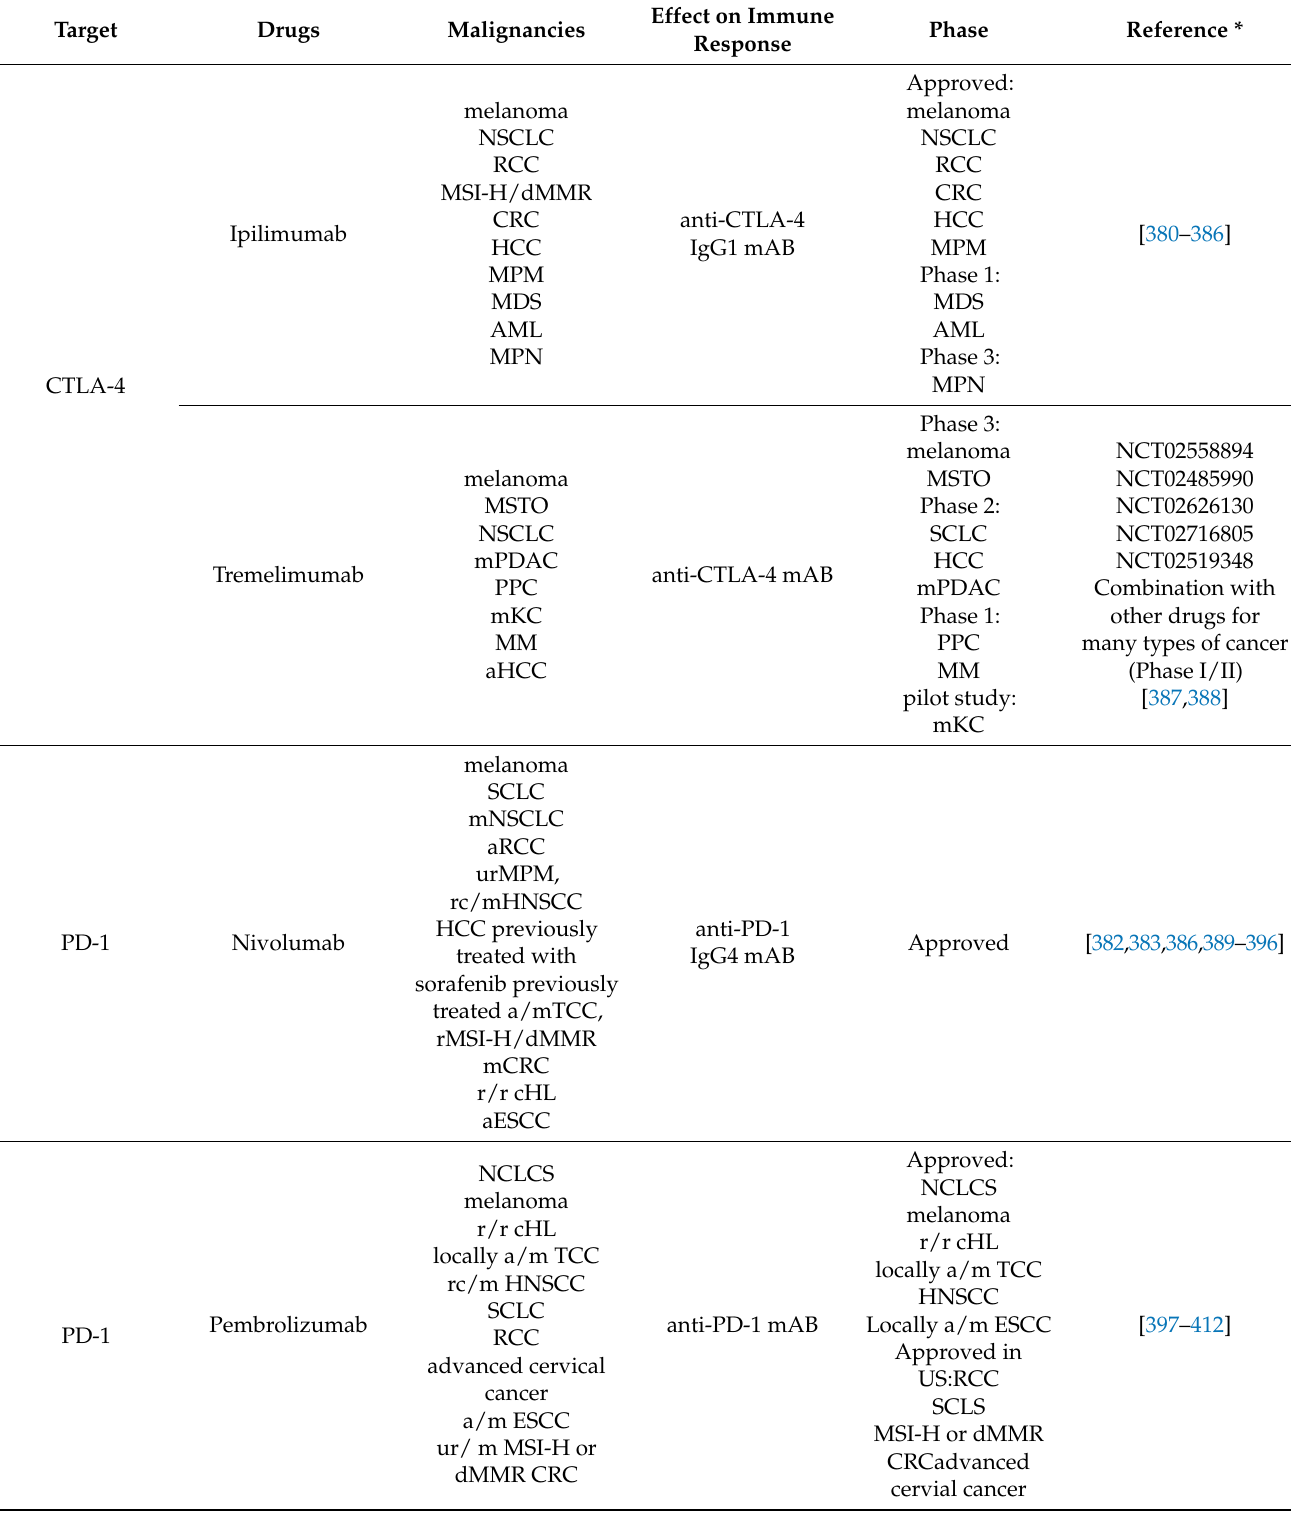
Table 5. Overview of TME targeting